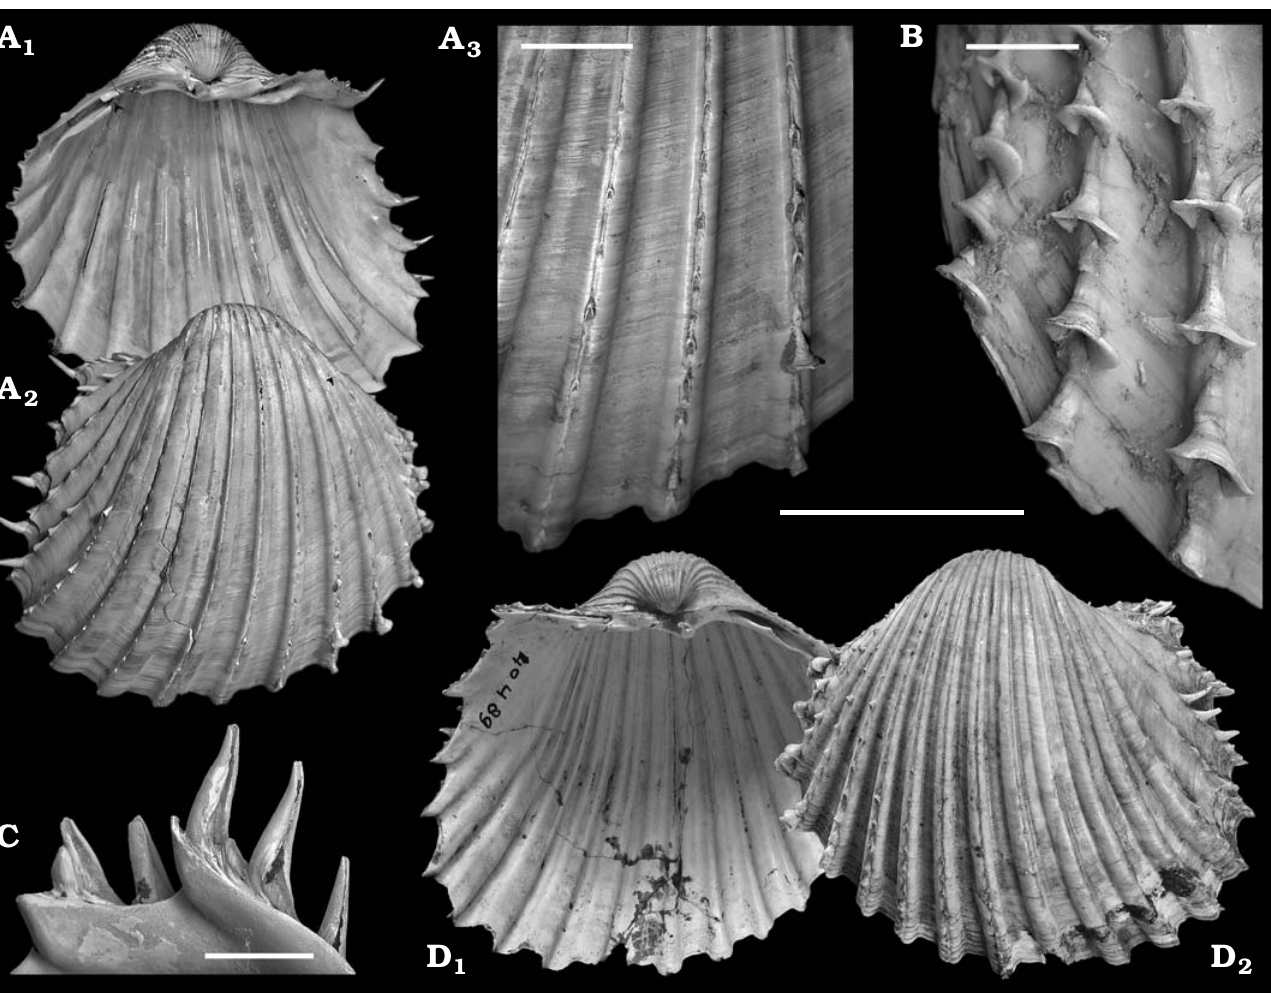
Fig. 4. Cardiid bivalve Procardium diluvianum (Lamarck, 1819) from Italy. A . MPUB 2017/1B, Pliocene, Cerignola; internal (A 1 ) and external (A 2 ) views, detail of sculpture (A 3 ). B . MPUB 2017/1A, Pliocene, Cerignola; detail of anterior sculpture. C . MPUB 2017/1A, Early Pleistocene, Gravina in Puglia; de- tail of posterior spines (inner view). D . PH 40489, Piacenzian (Pliocene), Castell’Arquato; internal (D 1 ) and external (D 2 ) views. Scale bars: A 1 , A 2 , D 1 , D 2 , 50 mm; A 3 , 10 mm; B, C, 5